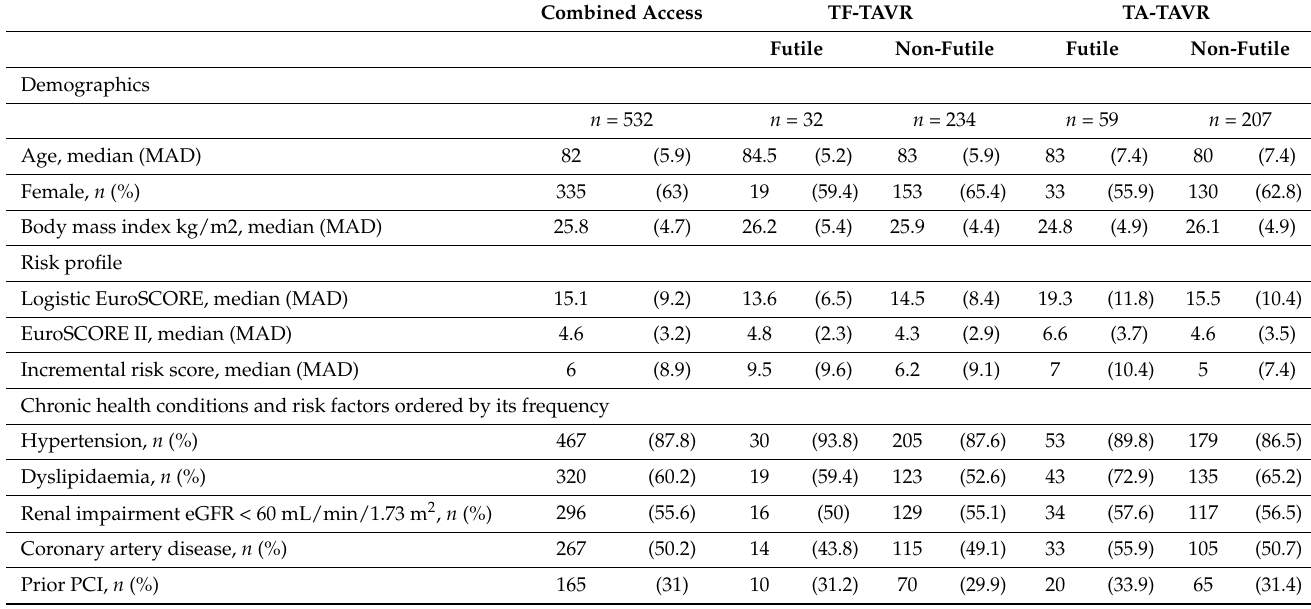
Table 1. Baseline clinical characteristics of futile and non-futile TAVR